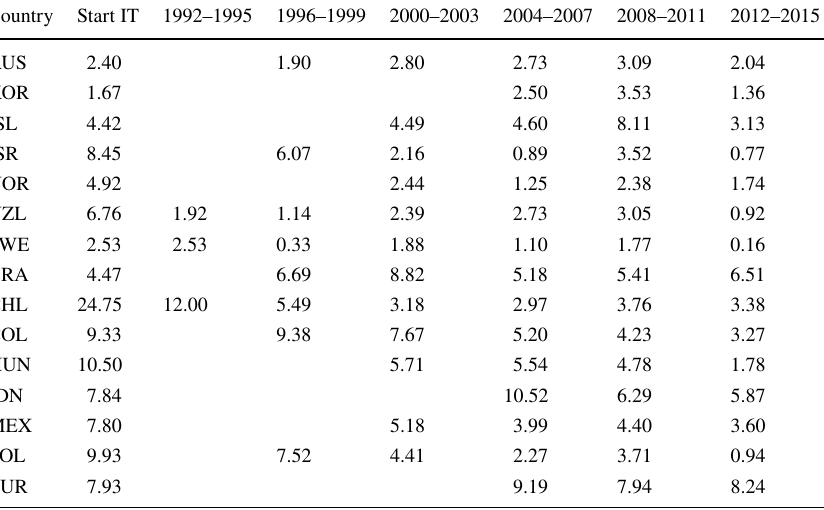
Table 1 Evolution of average annual inflation of IT countries. Source : Own elaboration